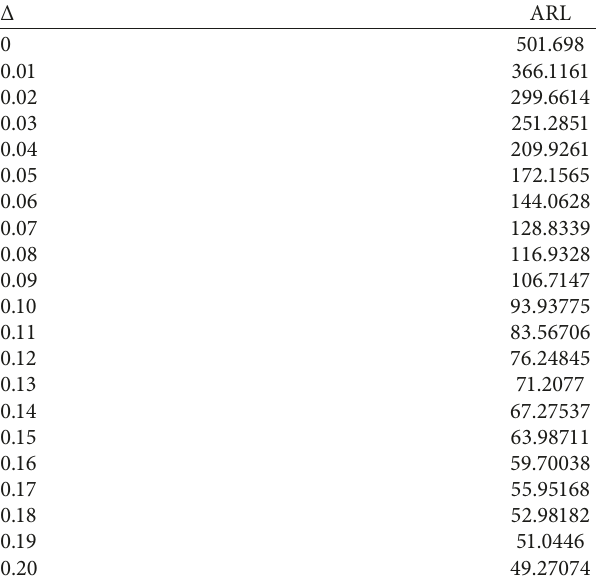
Table 11: Impact of estimation error for R h � 5 . 32.